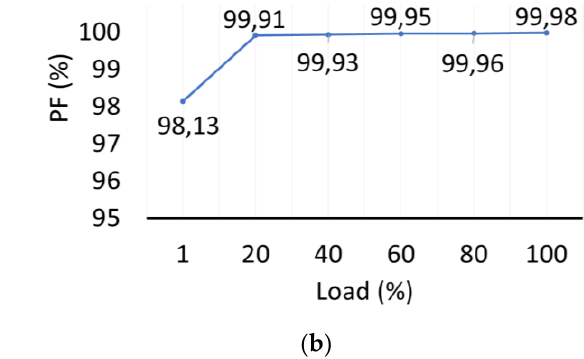
Figure 15. ( a ) THD for various load levels; ( b ) PF for various load levels.